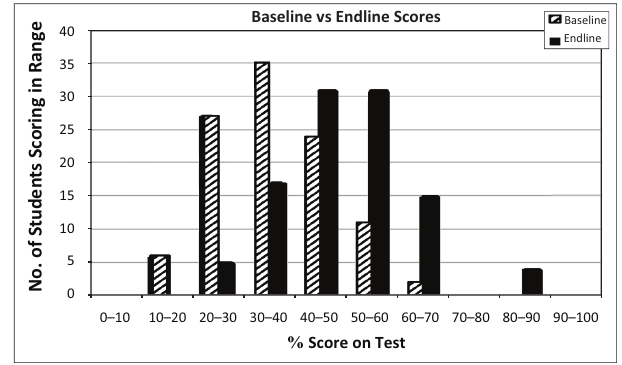
FIGURE 1: Number of mastery exercises.